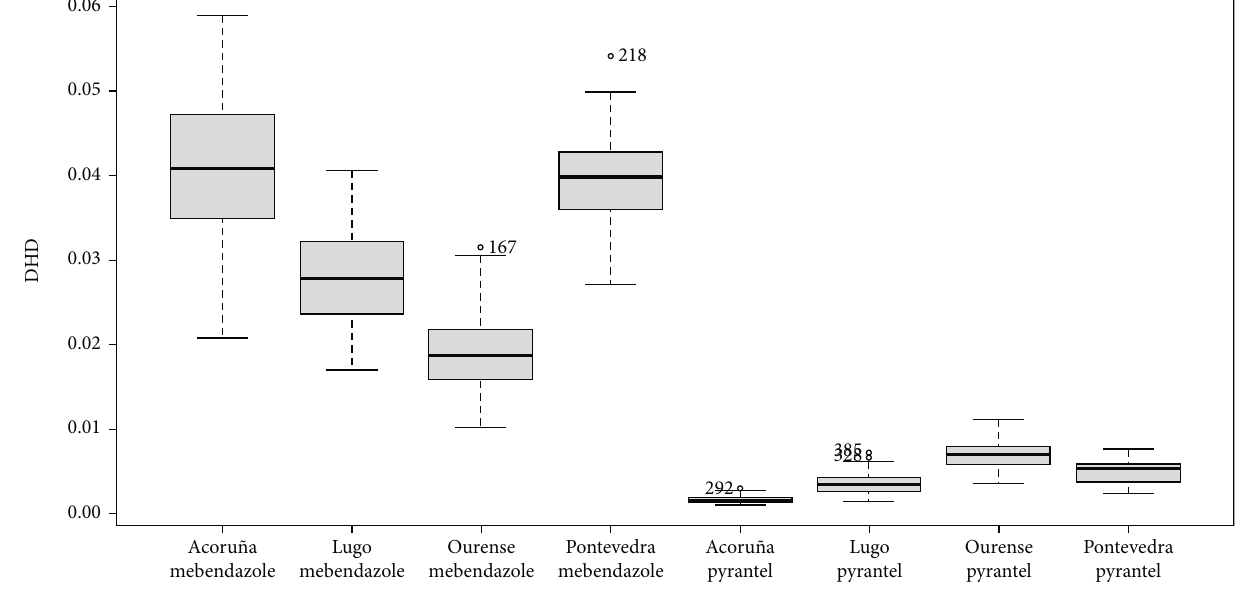
Figure 2: Distribution by province and active